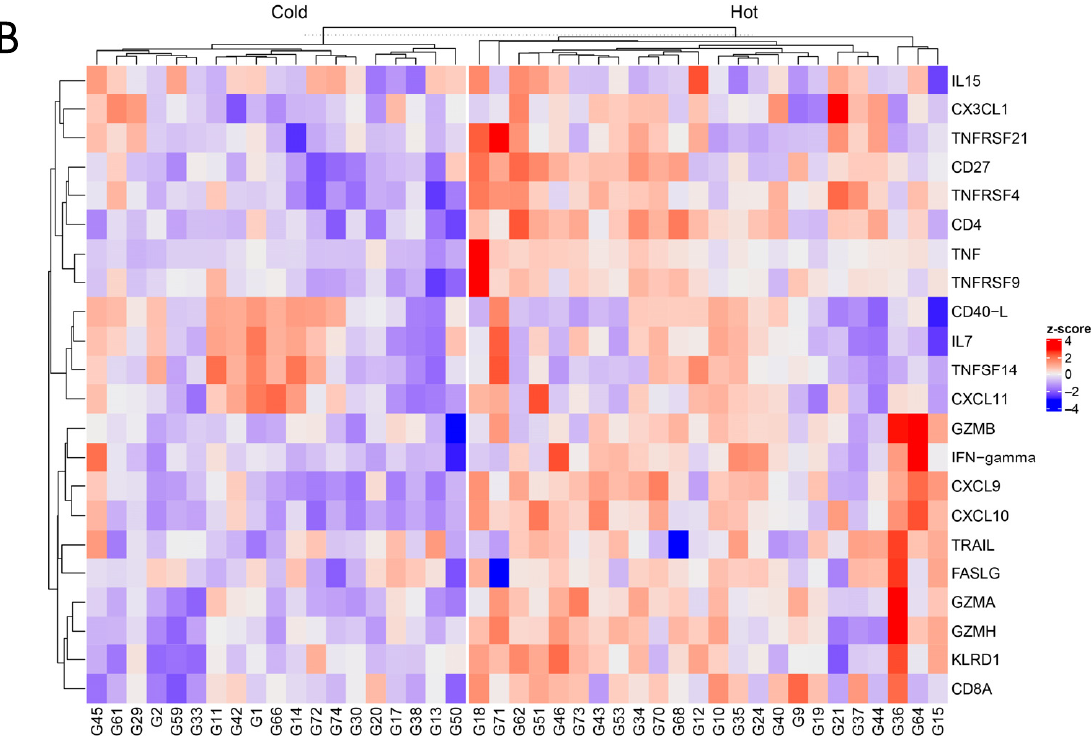
Figure 2. Hierarchical clustering analysis of protein expression. ( A ) Plasma from the patient cohort ( n = 43, 84 proteins passed quality control). Unsupervised clustering analysis was performed on pre-anti-PD-(L)1 therapy samples based on all the analyzed proteins that were within the assay detection limit (84 proteins). ( B ) K-means clustering analysis for selected T-cell activation-related markers (22 proteins) in the plasma. Normalized protein expression (NPX) is presented as a z- score.